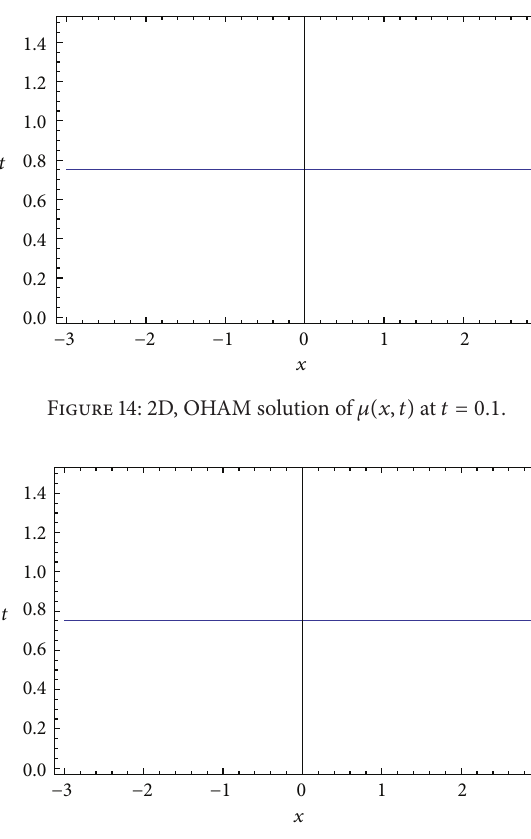
Figure 15: 2D, exact solution of 𝜇(𝑥,𝑡) at 𝑡 = 0.1